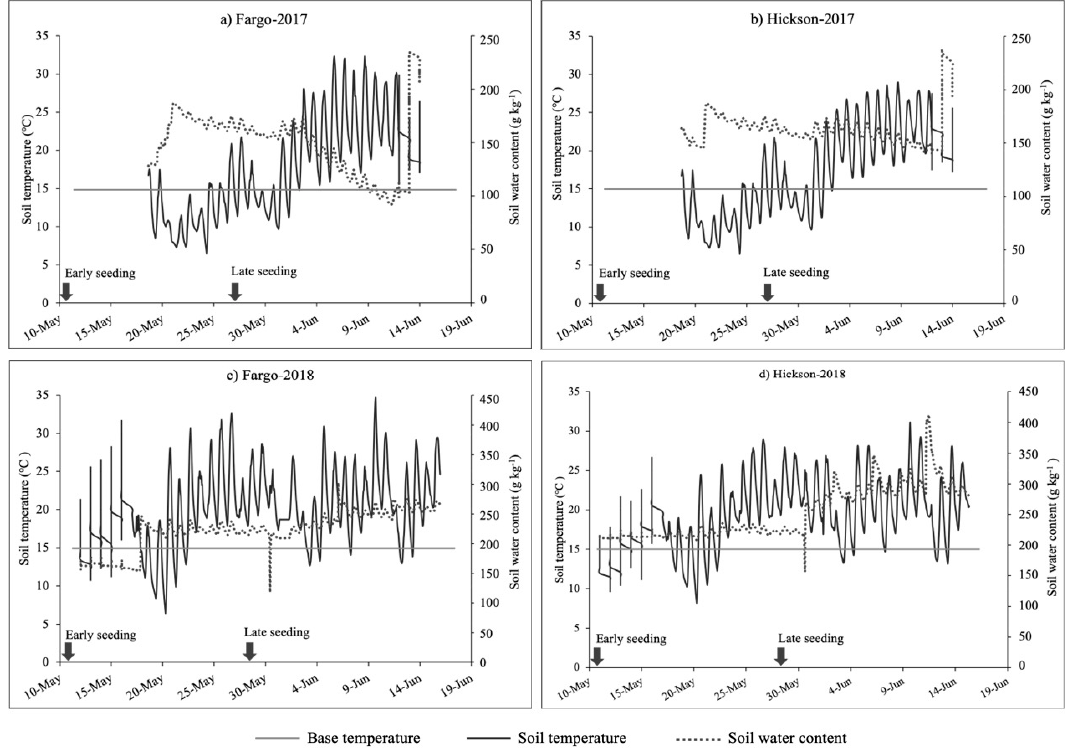
Figure 2. Soil temperature and soil water content from planting to the end of emergence at four environments at ( a ) Fargo 2017, ( b ) Hickson 2017, ( c ) Fargo, 2018, and ( d ) Hickson 2018, ND, USA.